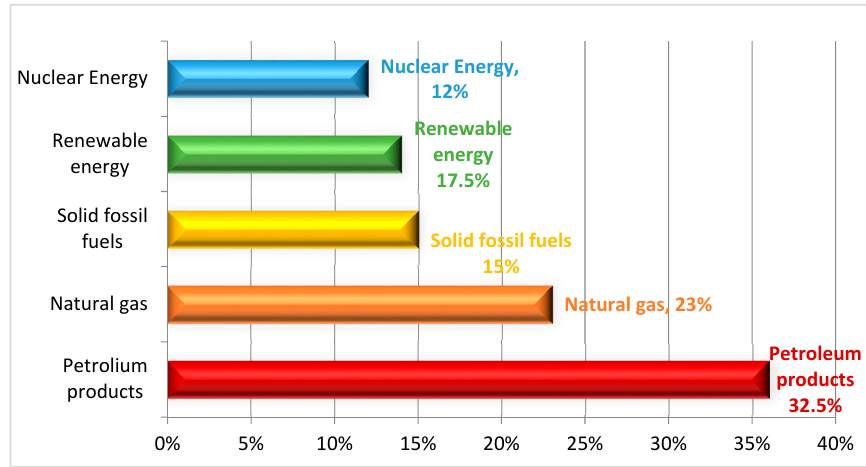
Figure 1. Energy mix produced in the EU in 2017. Source: own computations performed on data retrieved from Eurostat [18]. Mathematics 2020 , 8 , x FOR PEER REVIEW